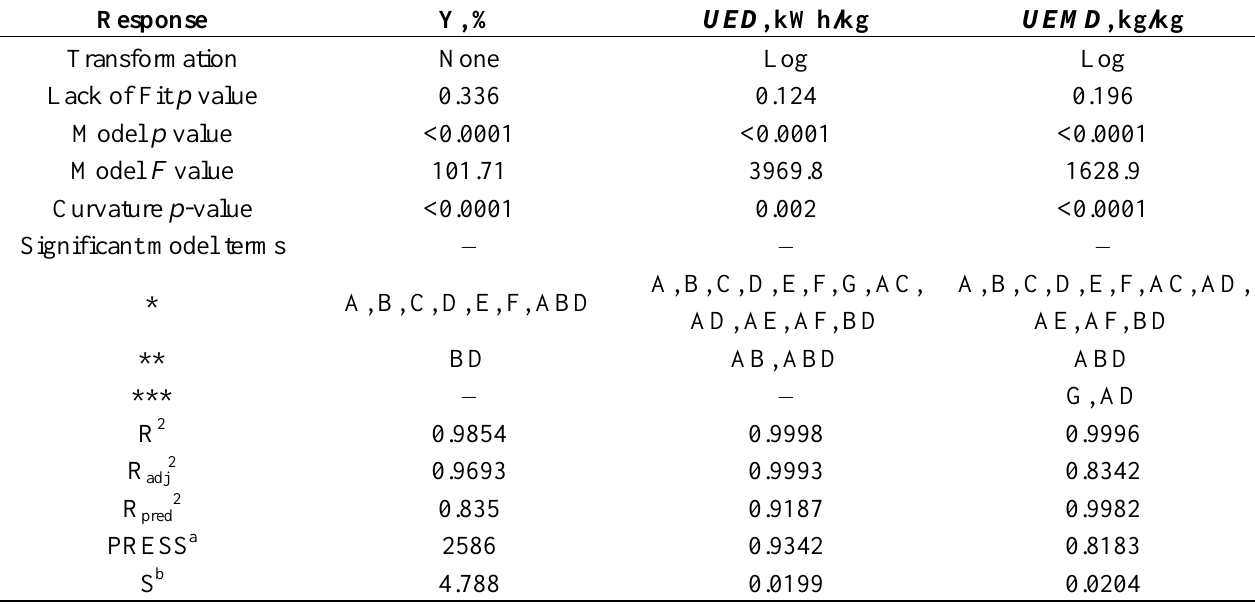
Table 4. Statistical summary of Y , UED and UEMD